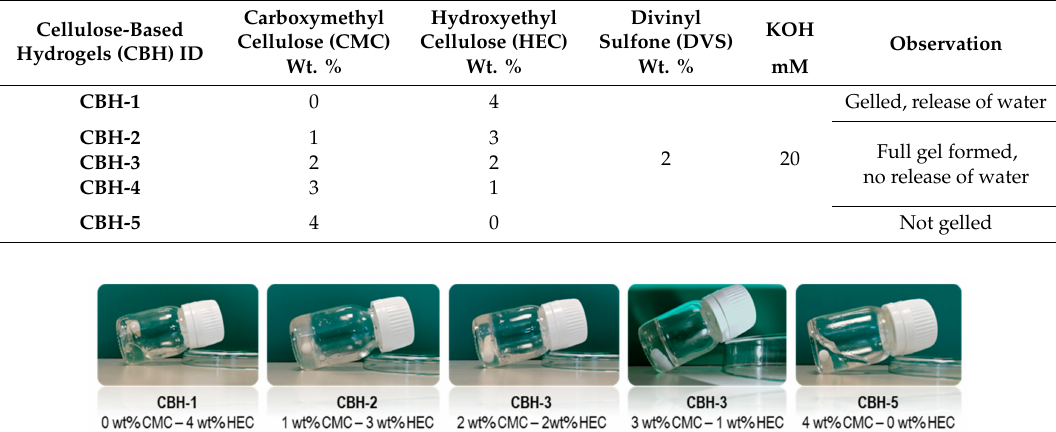
Figure 2. Digital images of gel appearance as a function of the cellulose derivatives’ weight ratio. CBH is the abbreviation for cellulose-based hydrogel; CMC for carboxymethyl cellulose and HEC for hydroxyethyl